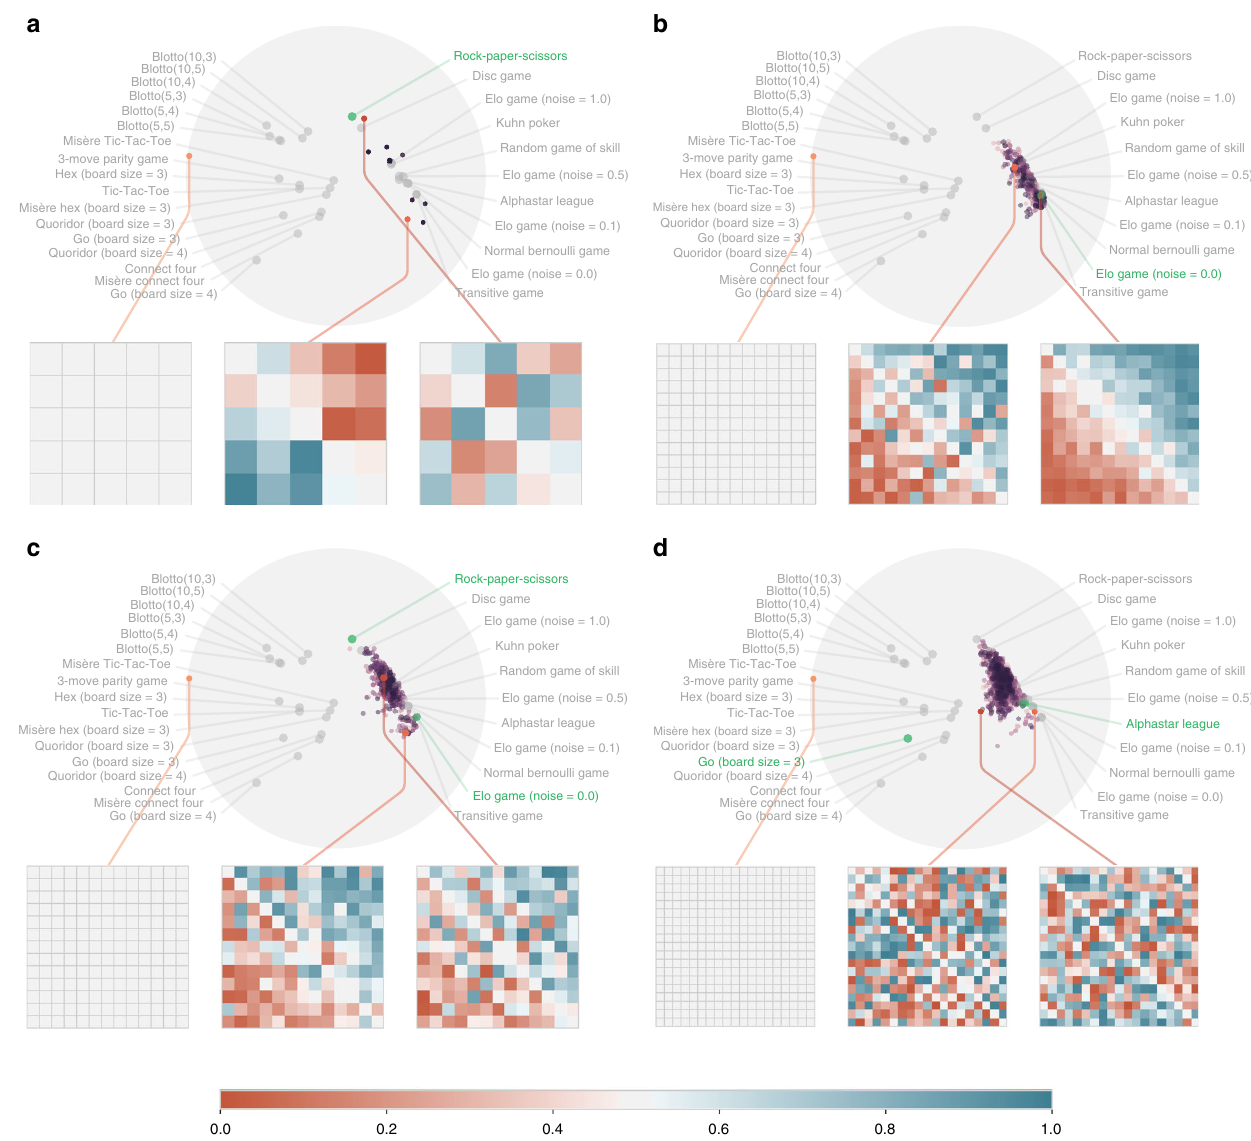
Fig. 10 Visualization of procedural game structure generation projected in the games landscape. Each fi gure visualizes the generation of a game of speci fi ed size, which targets a pre-de fi ned game (or mixture of games) of a different size. The three payoffs in each respective fi gure, from left to right, correspond to the initial procedural game parameters, intermediate parameters, and fi nal optimized parameters. a 5 × 5 generated game with the target game set to Rock – Paper – Scissors (3 × 3). b 13 × 13 generated game with the target game set to Elo (1000 × 1000). c 13 × 13 generated game with the target game set to the mixture of Rock – Paper – Scissors (3 × 3) and Elo game (1000 × 1000). d 19 × 19 generated game with the target game set to the mixture of AlphaStar League and Go (board size = 3). Strategies are sorted by mean payoffs in b and c to more easily identify transitive structures expected from an Elo